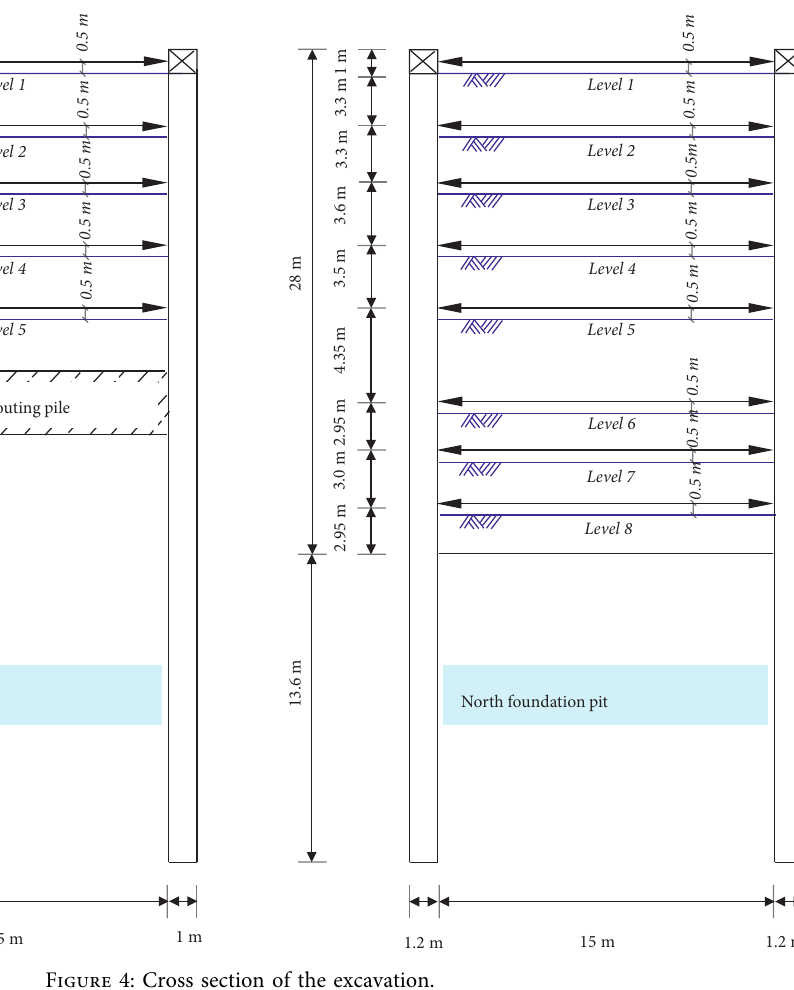
Figure 4: Cross section of the excavation.